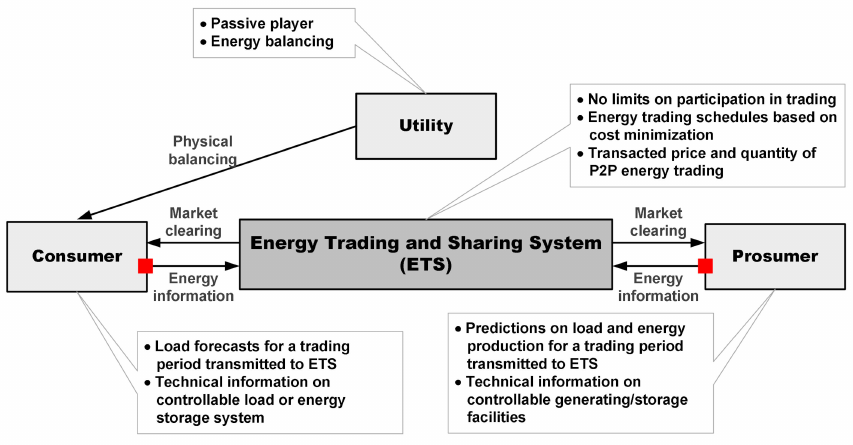
Figure 1. The conceptual framework of P2P energy trading